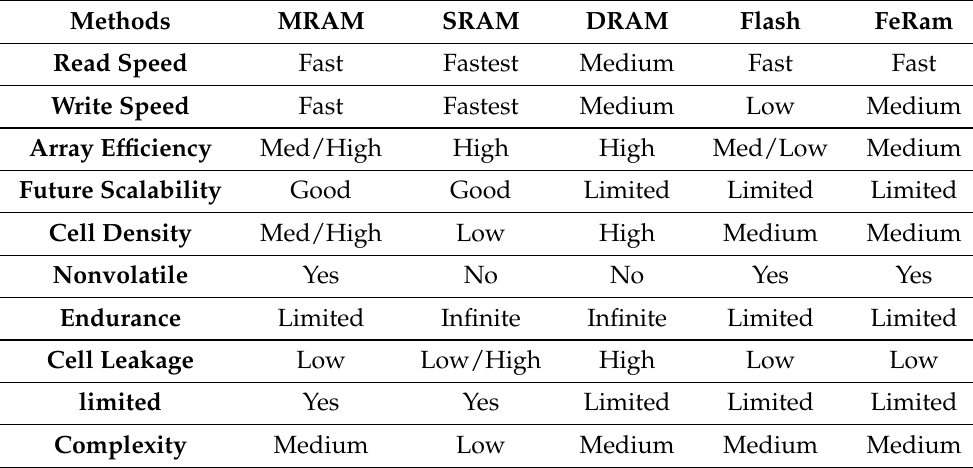
Table 1. Characteristics of memory architectures for